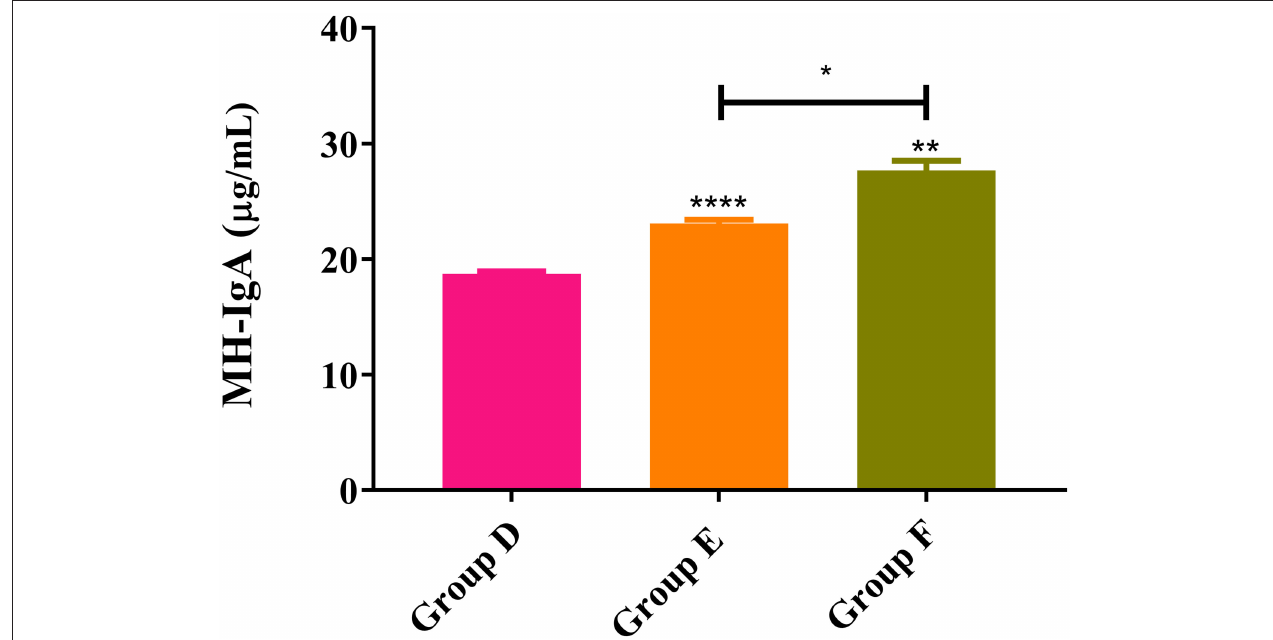
FIGURE 6 | MH-IgA contents detected in abomasum of trial 2. Group D, unchallenged goats; Group E, goats challenged with L3s; Group F, goats vaccinated by rHc8 antigen mixed with Freund’s adjuvants (at day 0 and 15), and challenged with L3s (at day 29). Data were expressed as mean ± SEM. ** p < 0.01, **** p < 0.0001 vs. blank group and a capped line designates two groups that differ significantly (* p <